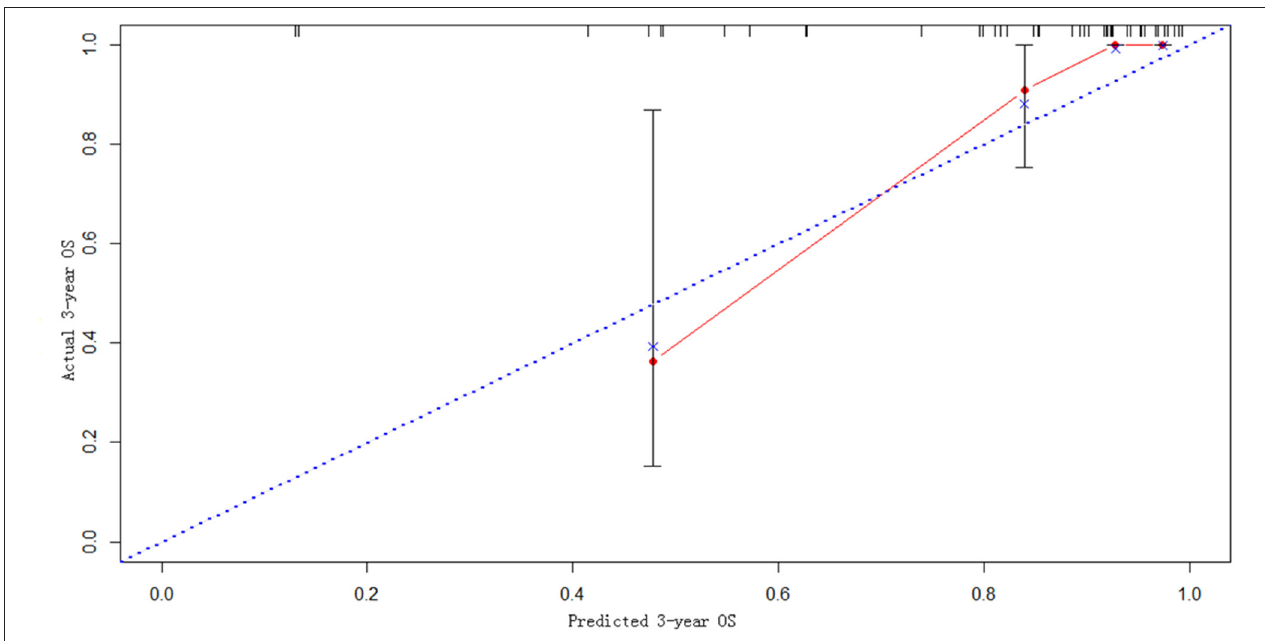
FIGURE 7 | Calibration curves for 3-year prediction in the validation